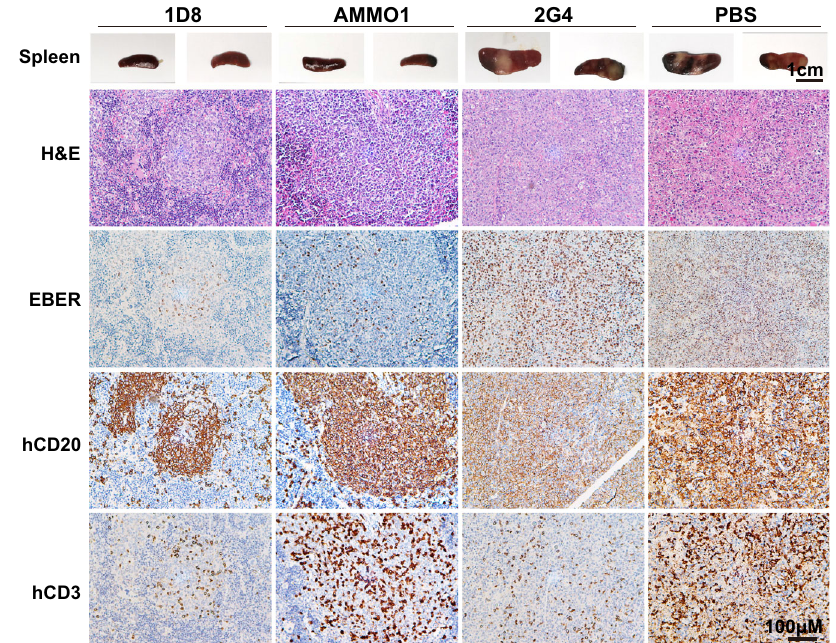
Fig. 3 1D8 reduces viral replication and tissue damages in humanized mice. Representative of macroscopic spleens and splenic sections stained for hematoxylin and eosin (H&E), EBV encoded RNA (EBER), human CD20 (hCD20), and human CD3 (hCD3) at necropsy. The scale bars are indicated. Each image is representative of a group of 7 – 8